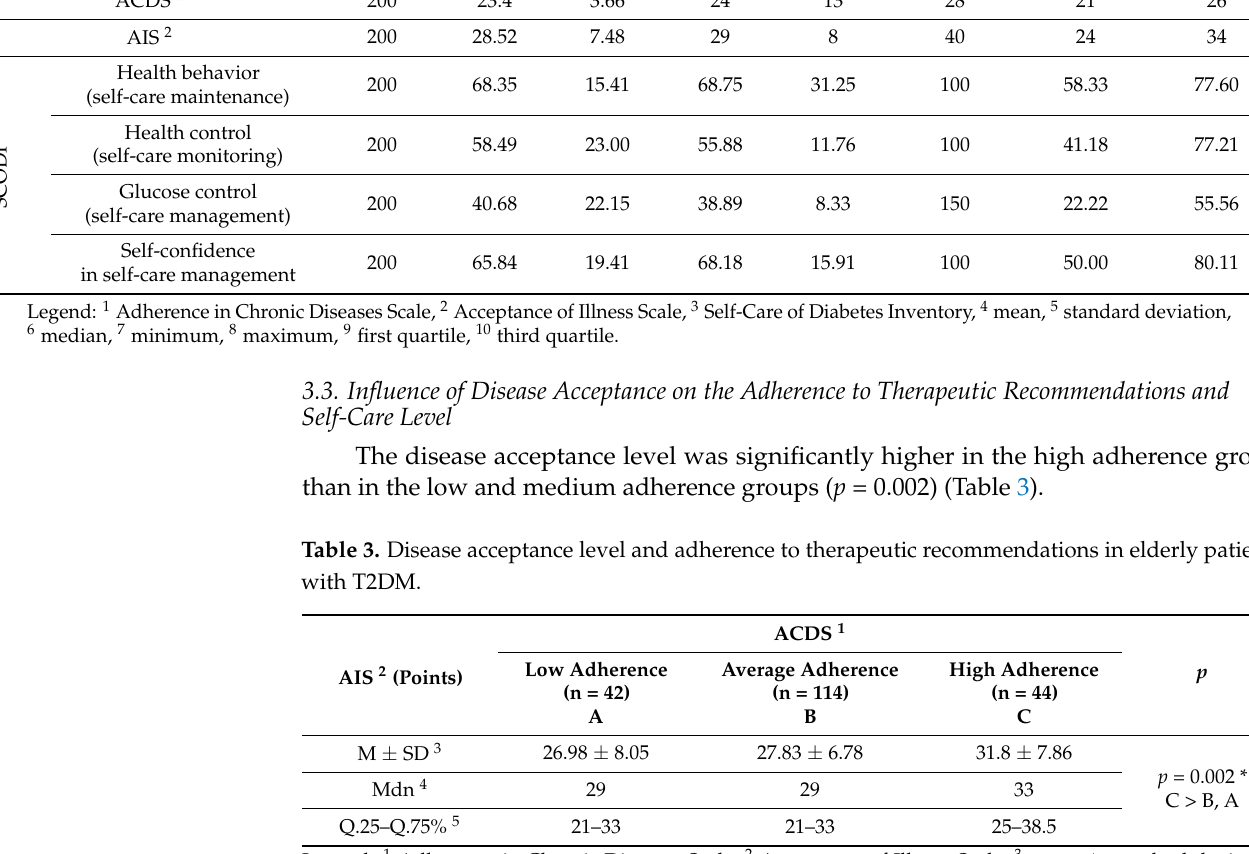
Table 2. Average measures for the degree of disease acceptance, self-care level regarding their diabetes, and adherence level. Tool n